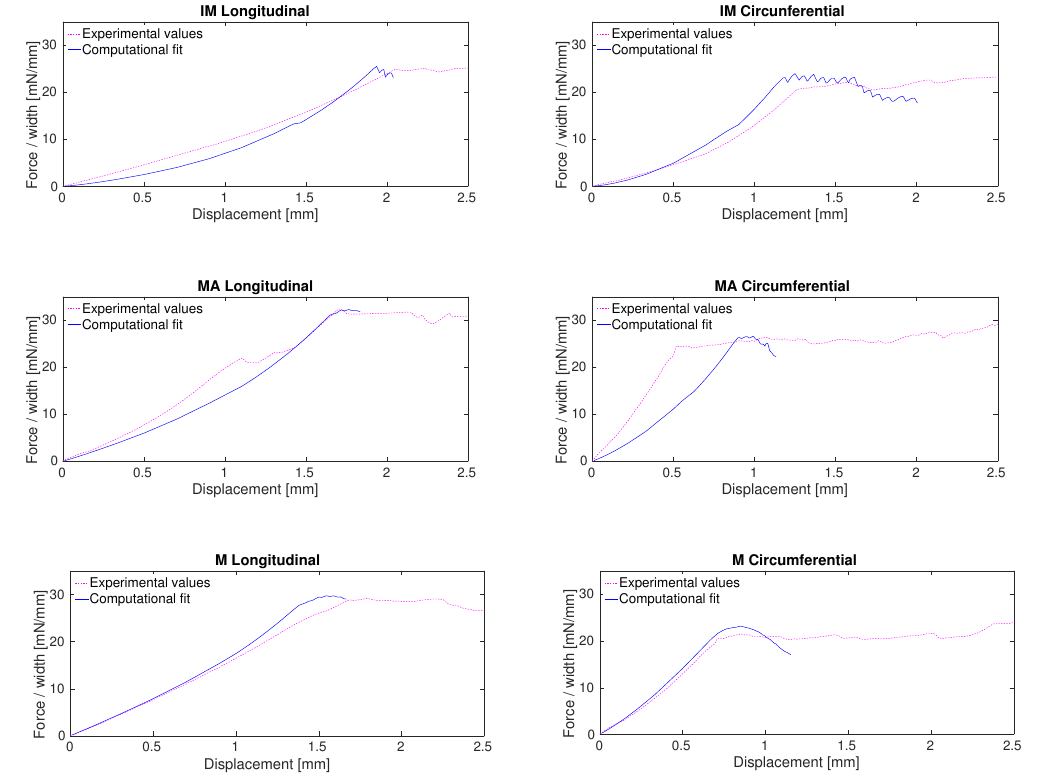
Figure 4. Correlation between force/width vs. displacement curves and computation of the peel test of the interfaces intima-media, media-adventitia and media for longitudinal and circumferential